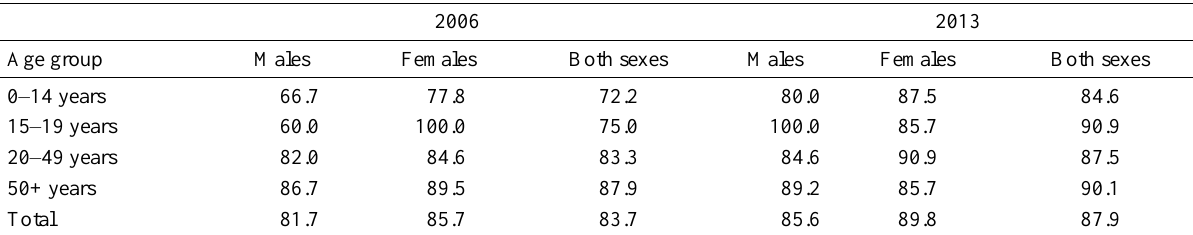
Table 10. English language spoken by Czech-born people by sex and age group (%), 2006 and 2013 censuses 2006 Age group Males